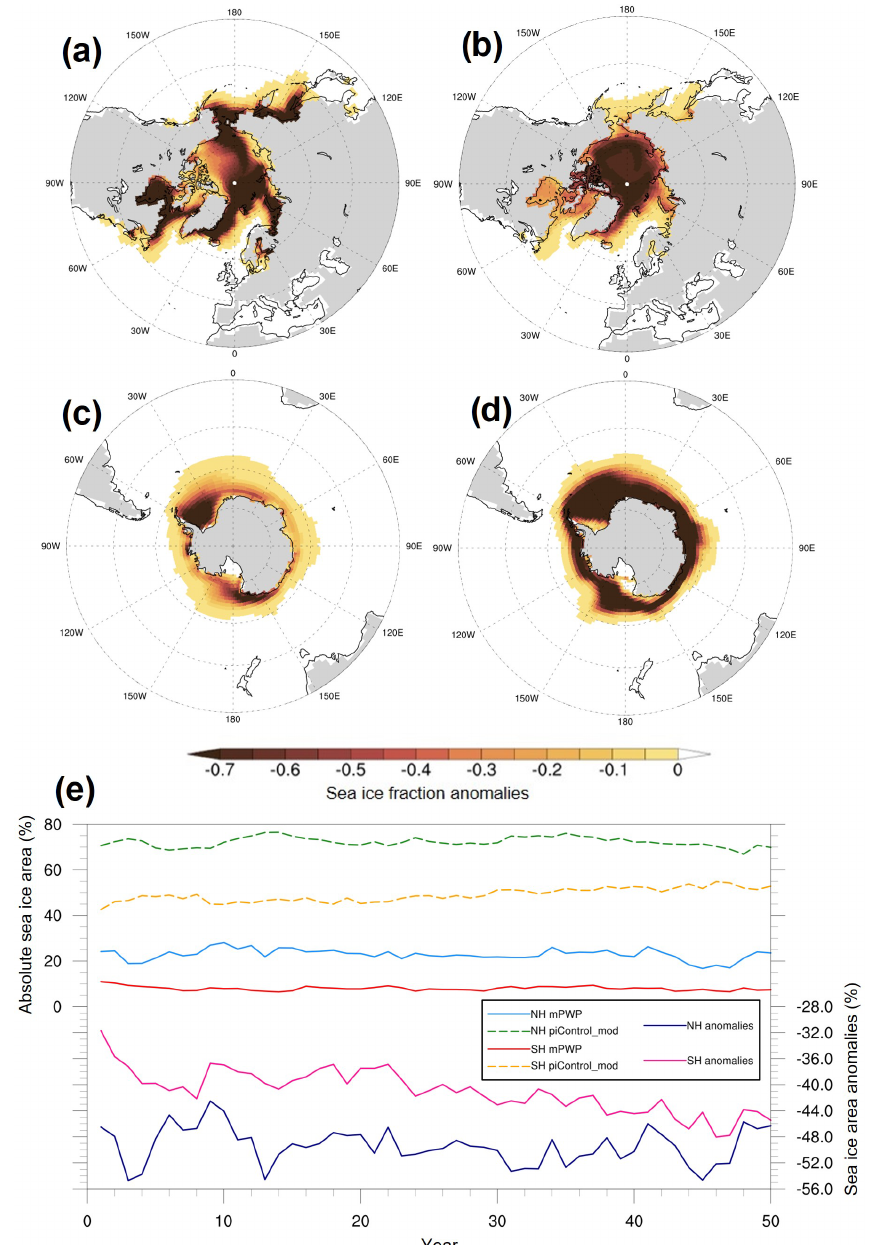
Figure 8. Sea ice fraction climatology differences ( mPWP − piControl_mod ) from HadGEM3: (a) Northern Hemisphere DJF, (b) Northern Hemisphere JJA, (c) Southern Hemisphere DJF, (d) Southern Hemisphere JJA and (e) mean sea ice area (both absolute values and differences) averaged over either